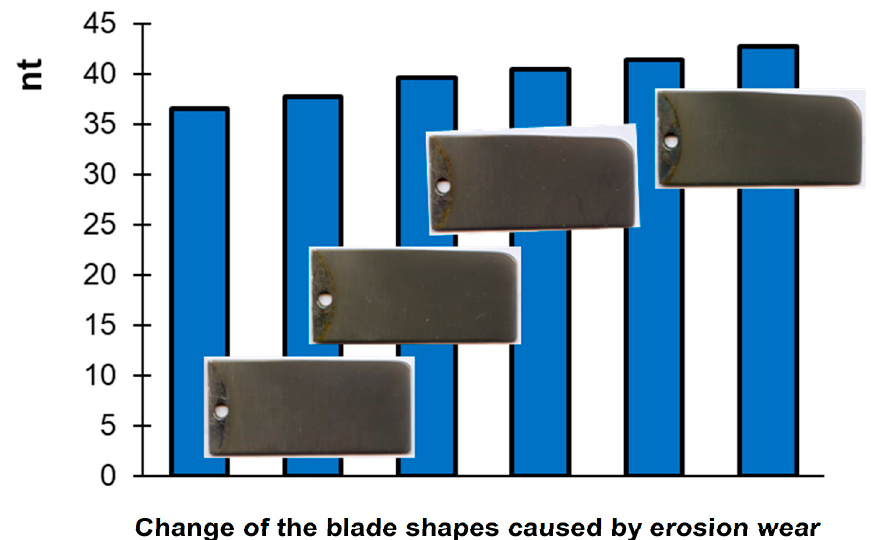
Figure 19. Influence of impeller blade wear on its dimensionless blending time.